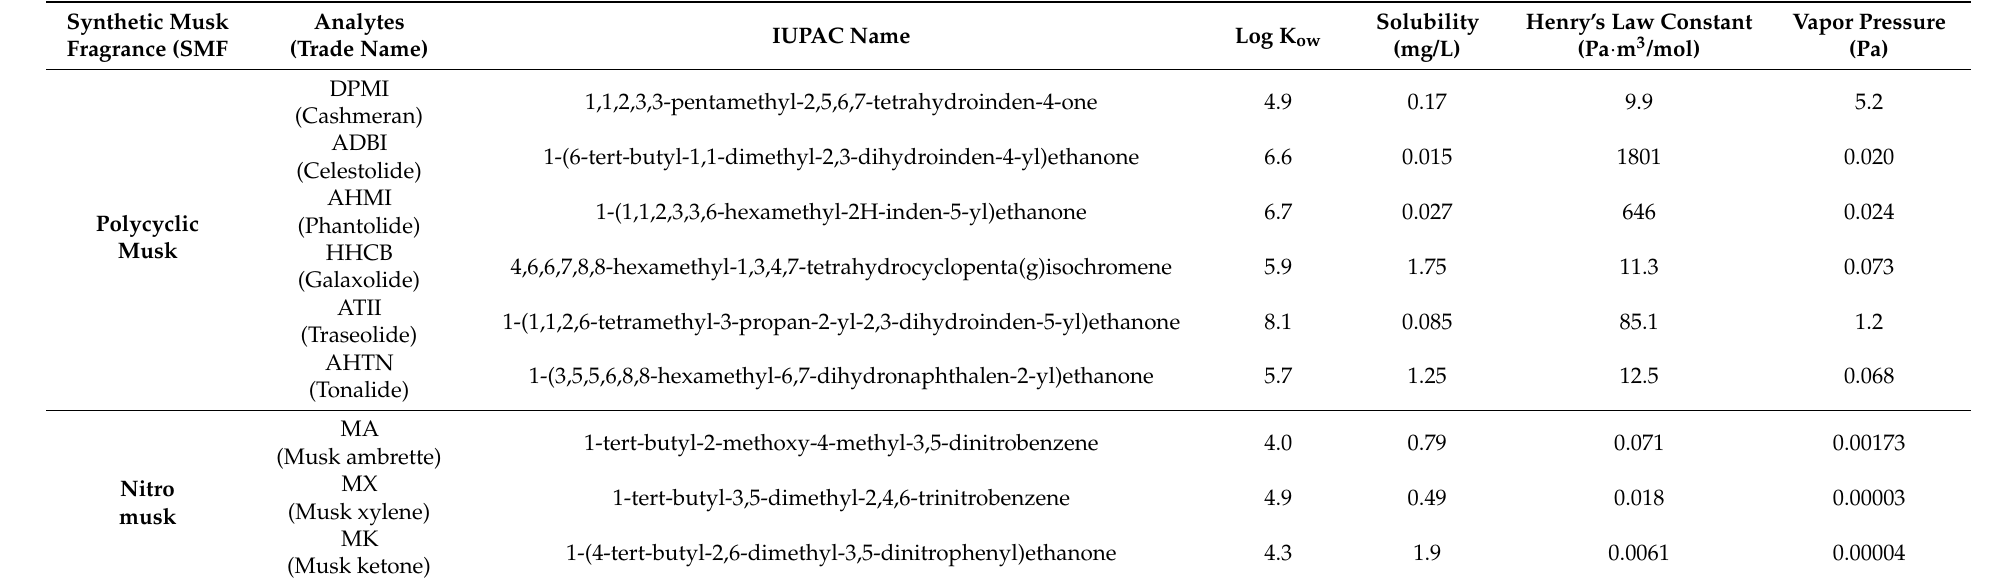
Table 1. Physicochemical properties of synthetic musk fragrances